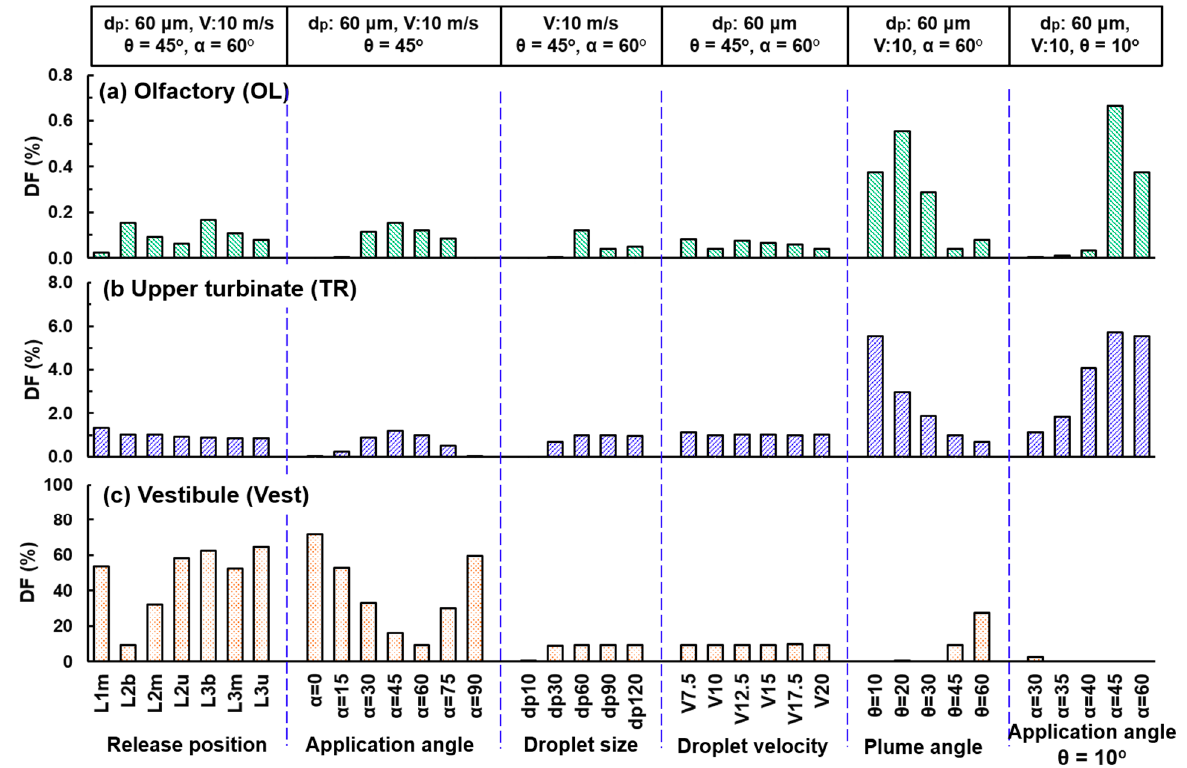
Figure 8. Comparison of the subregional DF among varying delivery scenarios in the ( a ) OL, ( b ) upper TR, and ( c ) Vest.